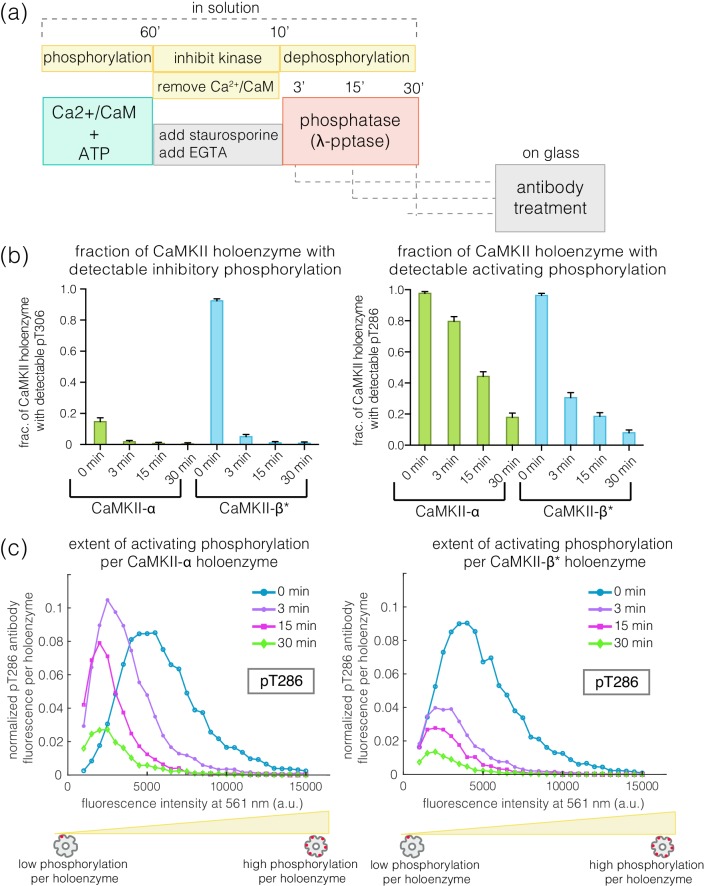
Measurement of dephosphorylation kinetics in solution.(a) Schematic diagram depicting the experimental design to measure dephosphorylation kinetics in-solution using λ-phosphatase. (b) Fraction of CaMKII-α/β* holoenzymes with detectable phosphorylation at Thr 305/306 (left) and Thr 286 (right) after 0, 3, 15, or 30 min of treatment with λ-phosphatase in-solution, when the kinase activity is switched off by staurosporine. (c) Intensity distribution for pThr 286 (561 nm) for CaMKII-α (left panel) and CaMKII-β* (right panel) holoenzymes with detectable phosphorylation at Thr 286 after 0, 3, 15, or 30 min of λ-phosphatase treatment (see Materials and methods for details of normalization).